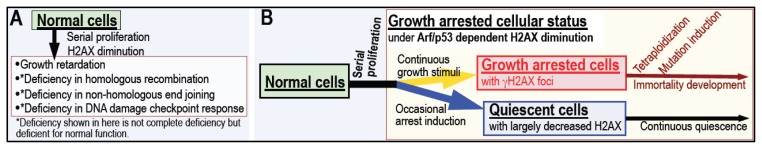
Arf/p53-dependent decrease of H2AX contributes to the characteristics of the growth-arrested state. Normal cells in a growth-arrested state due to a decrease in Arf/p53-dependent H2AX levels show similar characteristics to cells in which H2AX is either knocked-out or knocked-down (A). However, these growth-arrested states are discriminated by either a marked decrease in H2AX levels or by the accumulation of γH2AX (B), resulting in either continuous quiescence or tetraploidization and immortalization, respectively.